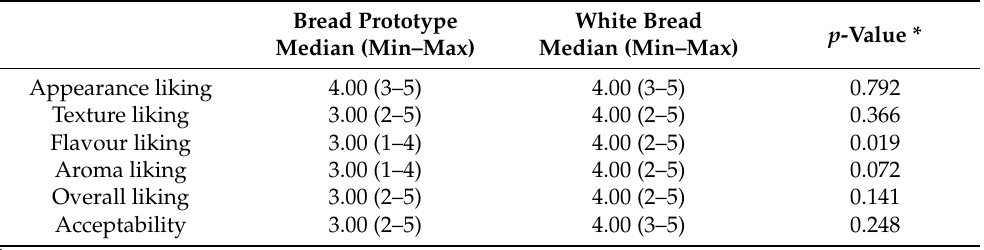
Table 3. The median scores 1 for the liking and acceptability of the bread prototype and white bread, and the comparison of these two types of bread ( n = 11). Bread Prototype Median